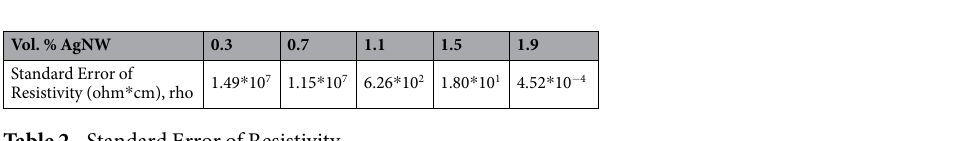
Table 2. Standard Error of